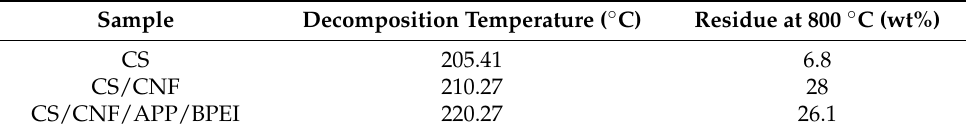
Table 1. Decomposition temperature and residue of the CS-based films.